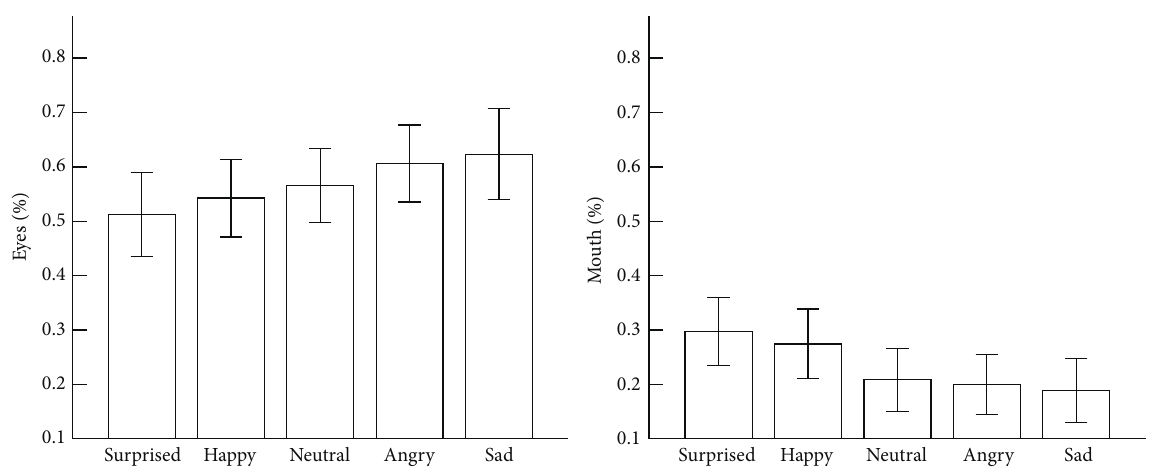
Figure 2: Mean proportion of total time spent looking at the eyes AOI and the mouth AOI for each facial expression category. The error bars indicate 95% confidence